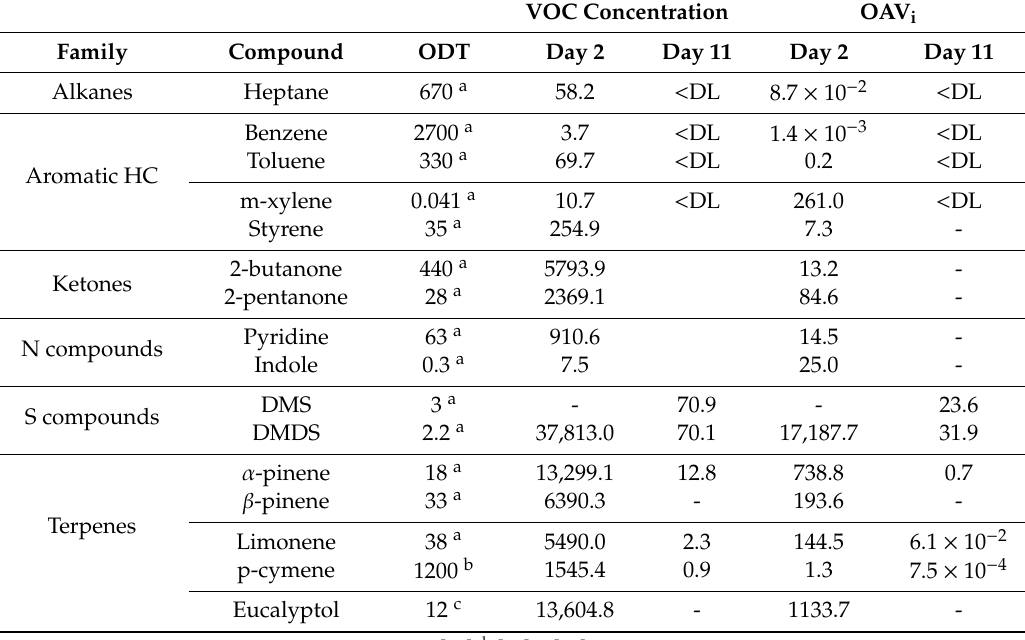
Table 4. VOCs quantified in the gaseous emissions generated during the sewage sludge composting process (concentration expressed in ppb v ), with its odour detection threshold (ODT, ppb v ) and the calculated OAV i (“ < DL”: compound concentration below the detection limit; “ − ”: compound not detected).